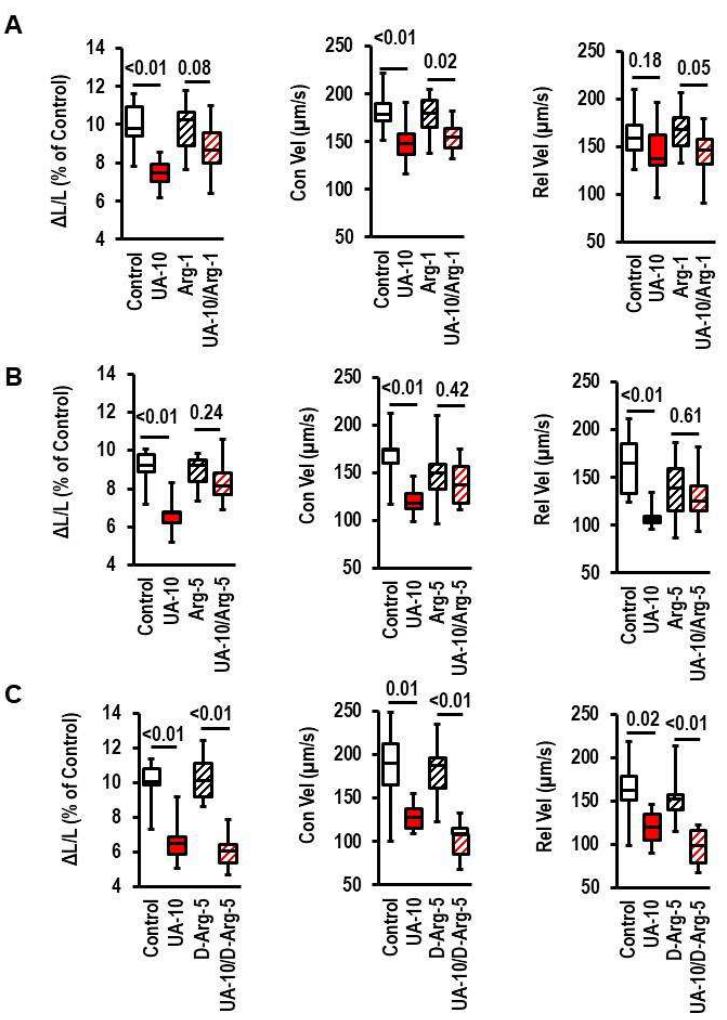
Figure 4. Effect of arginine supplementation on cell shortening and uric-acid (UA)-induced effects. Cells were exposed to L-arginine (Arg-1; 1 µmol/L; Arg-5, 5 µmol/L) or D-arginine (D-Arg, 5